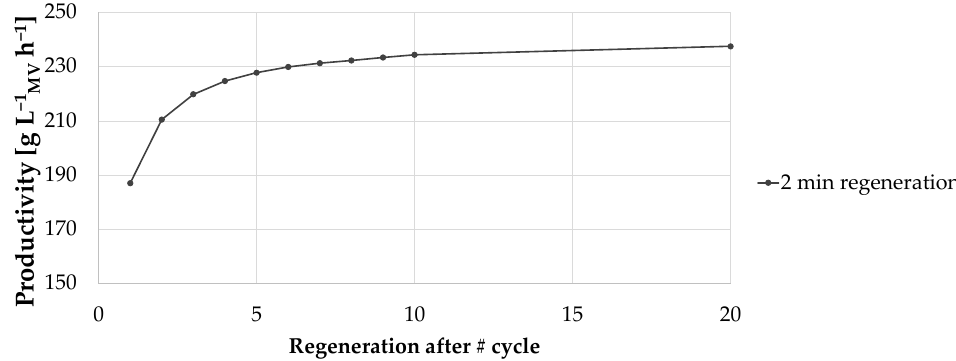
Figure 9. Productivity in dependency to the regeneration frequency, exemplary shown for low feed titer. Black dots constitute a regeneration duration of 2 min.